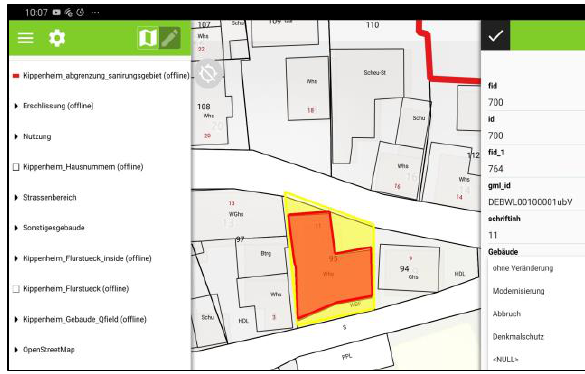
Figure 6: QField interface of intuitive data acquisition on-site.